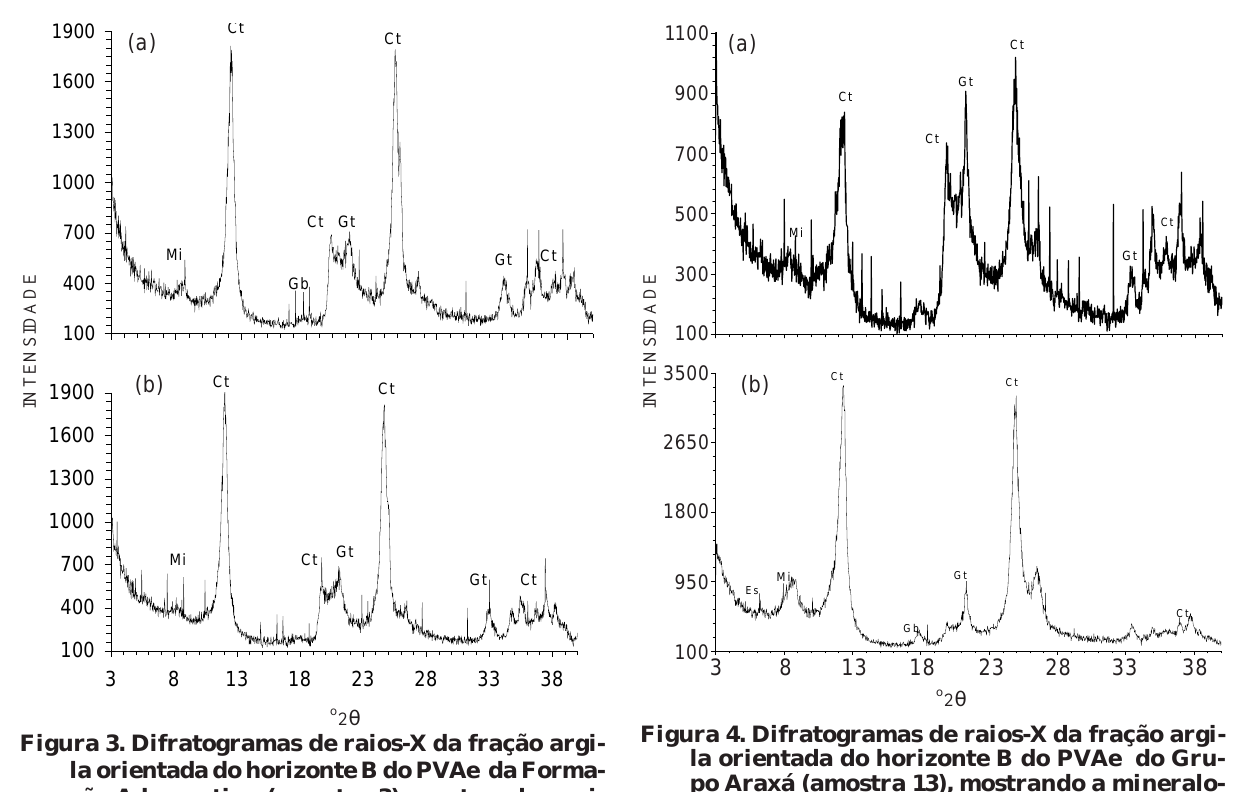
R. Bras. Ci. Solo, 29:533-545, 2005